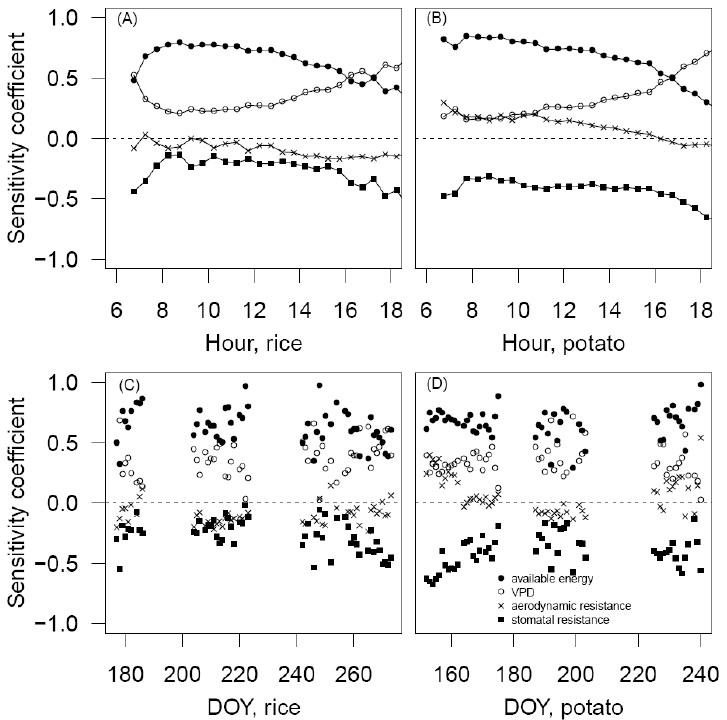
Figure 2 . Diurnal ( A , B ) and seasonal ( C , D ) patterns of Penman-Monteith model sensitivity coefficients for available energy (closed circle), vapor pressure deficit (VPD, open circle), aerodynamic resistance (cross), and stomatal resistance (closed square) in the rice field ( A , C ) and in the potato field ( B , D ).